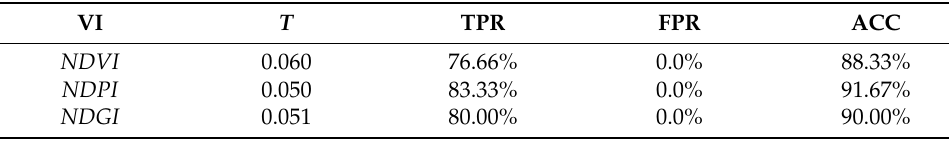
Figure 7. ROC curves of each vegetation index: FPR, false positive rate; TPR, true positive rate. Table 2. Optimal thresholds ( T ), error indices, and accuracy.